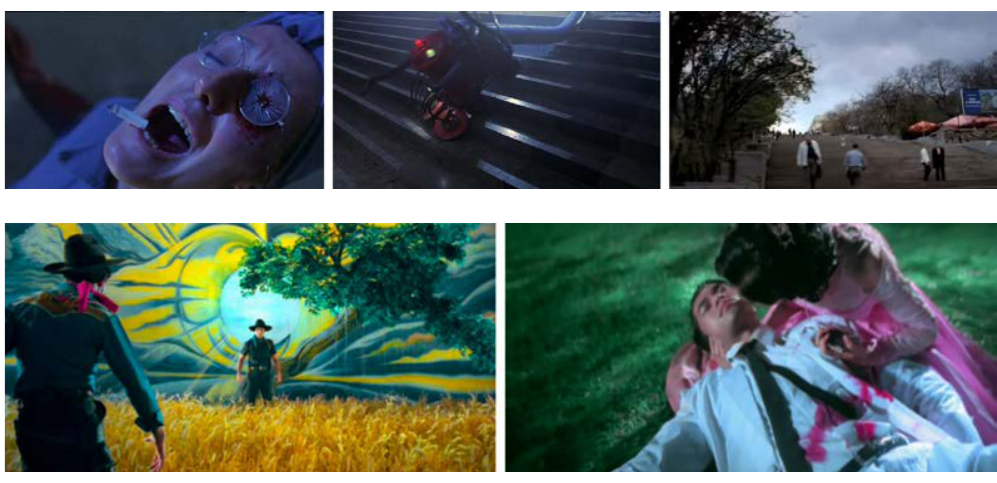
Fig. 4 Terry Gilliam, Brazil , 1985 (left, centre); Liev Screiber, Everything is illuminated , 2005 (right). Fig. 5 Wisit Sartsanatieng, Tears of the Black Tiger ,